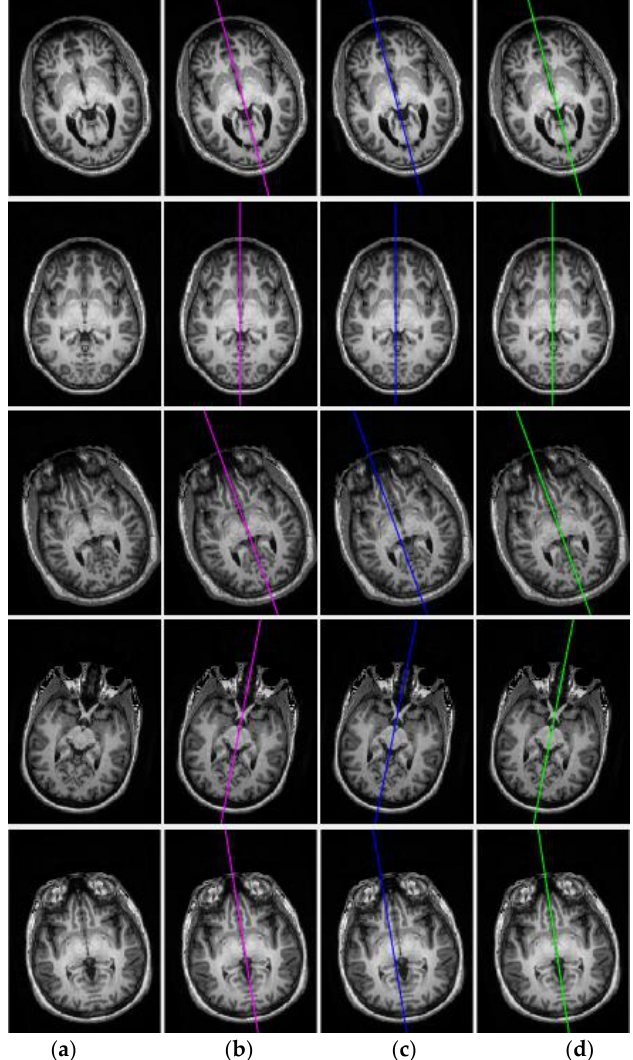
Figure 11. Visual comparison of the proposed algorithm with Ruppert et al. algorithm for extracting the symmetric axis (MSP) from perfectly symmetric datasets: ( a ) input slice, ( b ) ground-truth slice, ( c ) Ruppert et al. [27] algorithm results, and ( d ) proposed algorithm results.